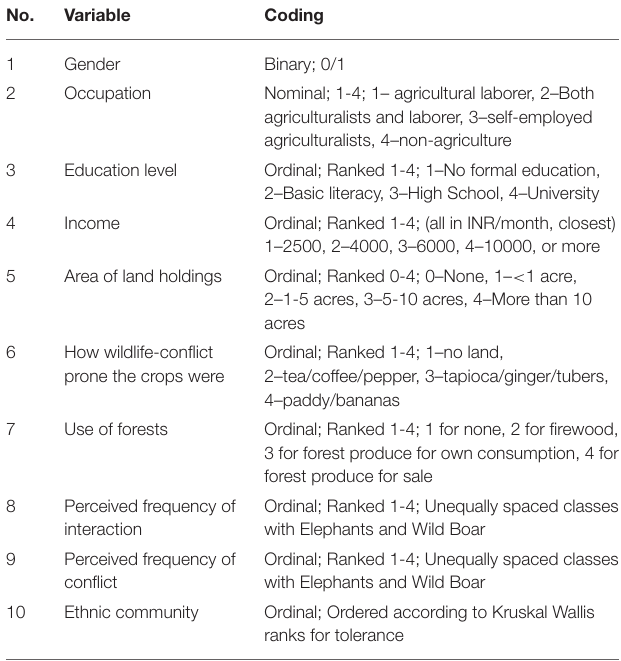
TABLE 2 | Coding of socio-ecological and HWC variables for correlation.